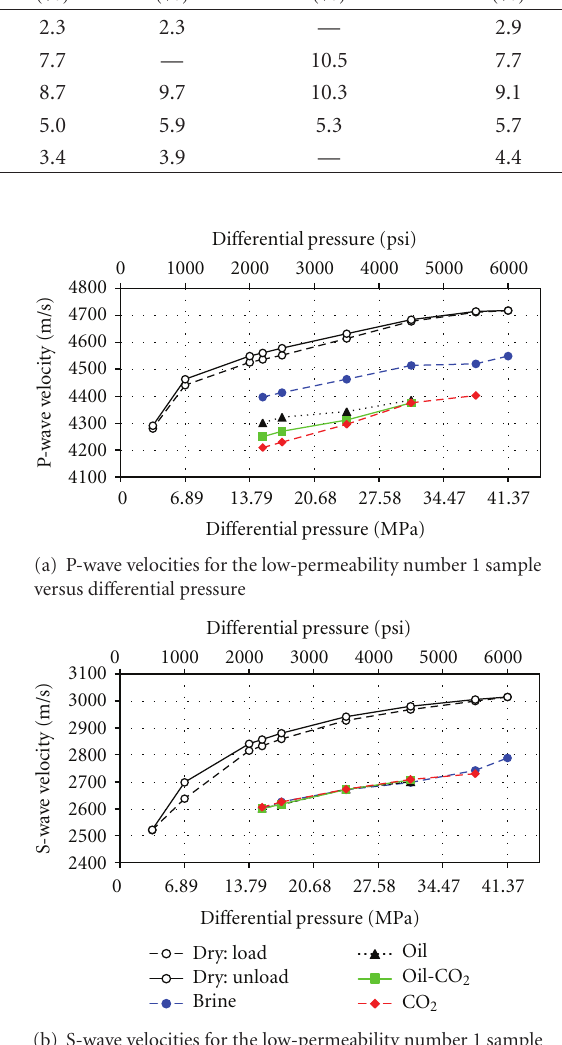
Table 4: Percentage change of S-wave velocity with increasing di ff erential pressure from 15.17 MPa to 37.92 MPa. Sample